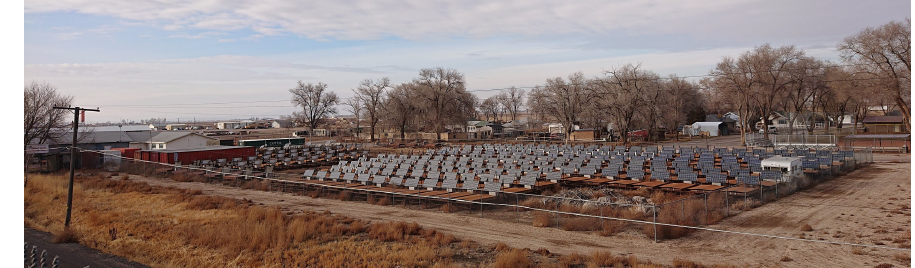
Figure 1. Picture of assembled SDs. These SDs will be deployed in the observation sites.